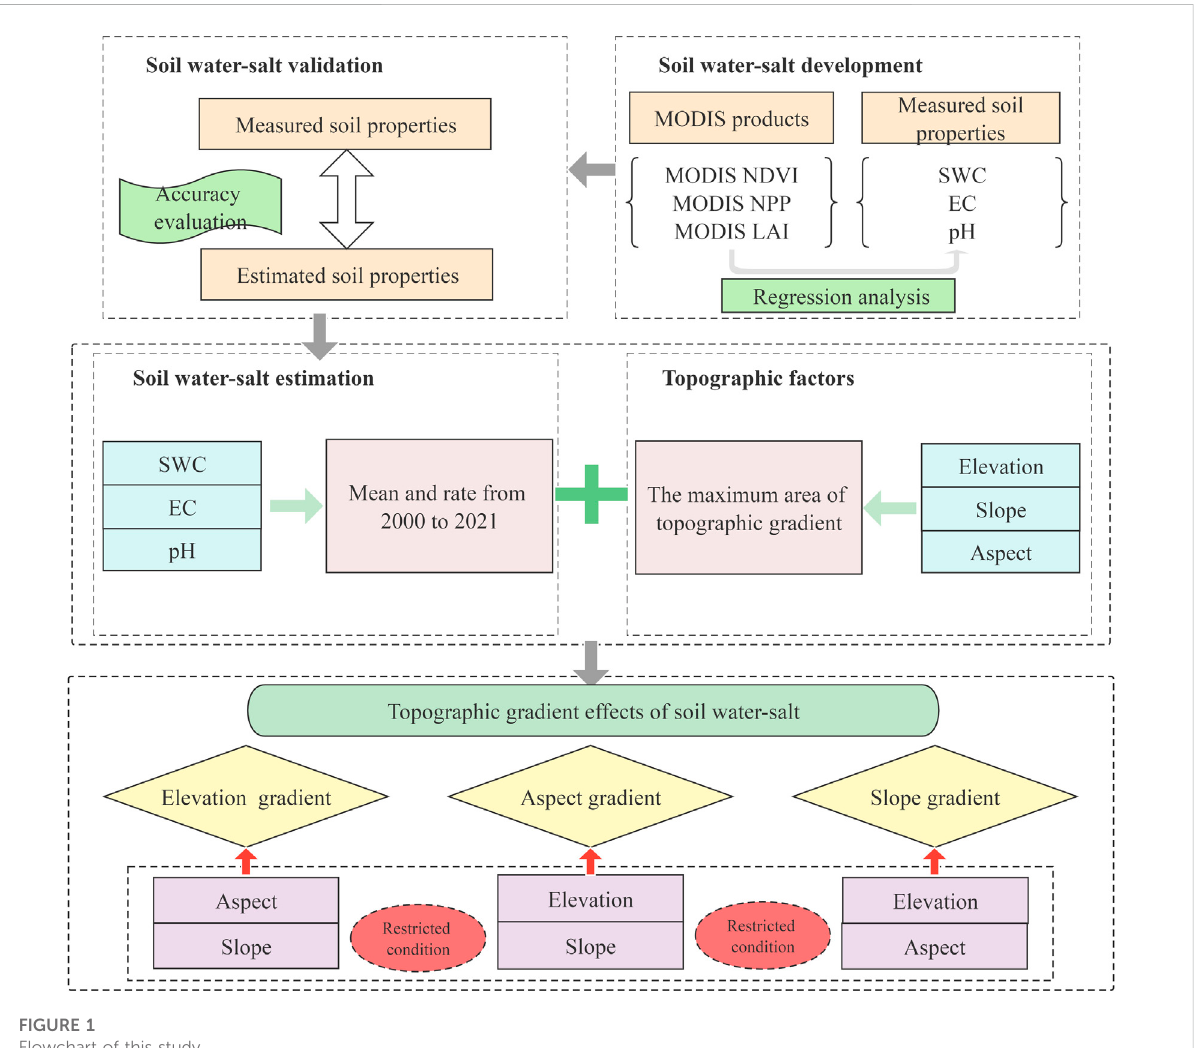
FIGURE 1 Flowchart of this